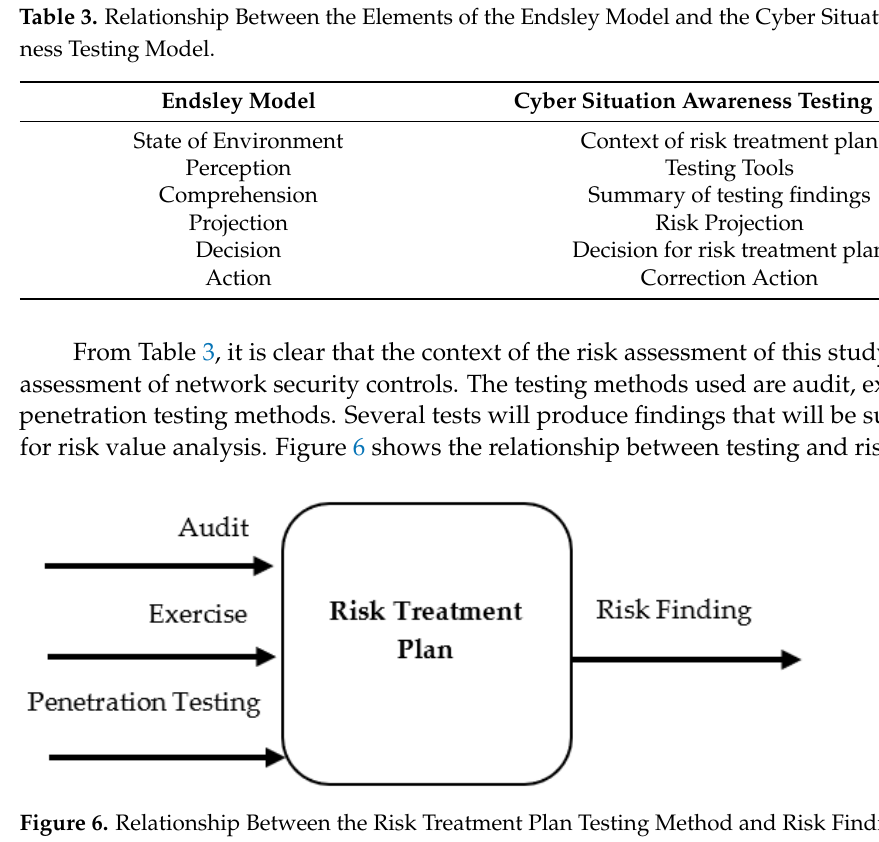
Figure 6. Relationship Between the Risk Treatment Plan Testing Method and Risk Finding.